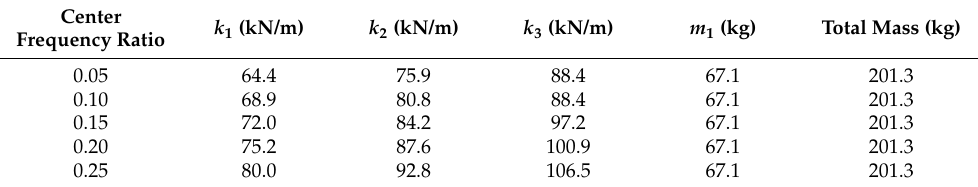
Table 9. Design parameters of MTMD under different center frequency